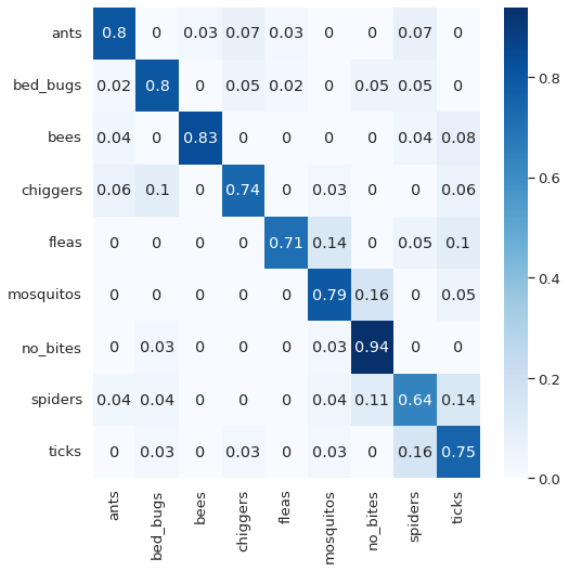
Figure 14. Normalized confusion matrix for